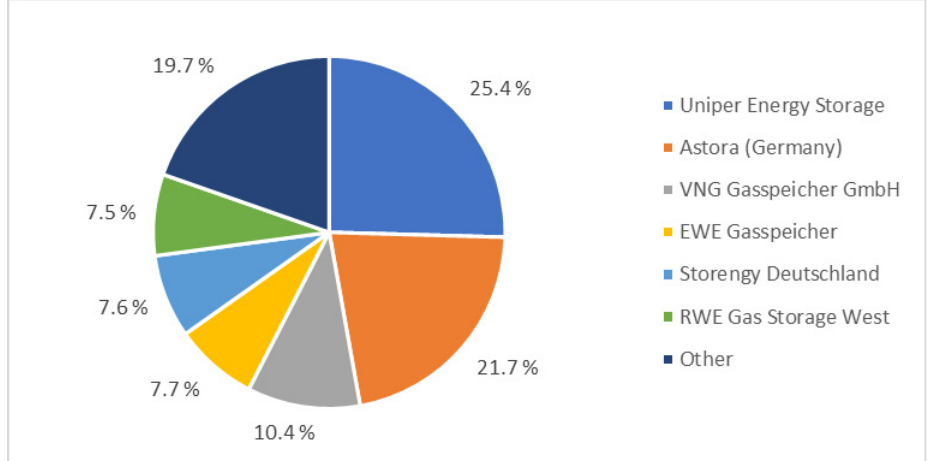
Figure 4. Storage operators’ percentage shares of Germany’s total working volume of 22 bcm. Source: [44] .